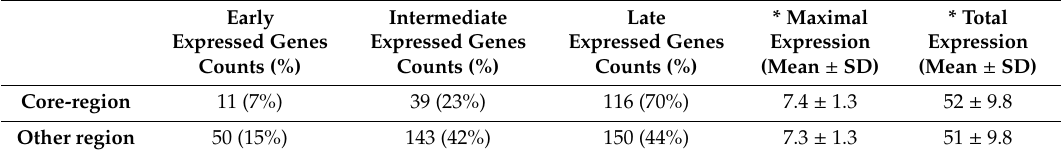
Table 2. RNA-seq gene expression in